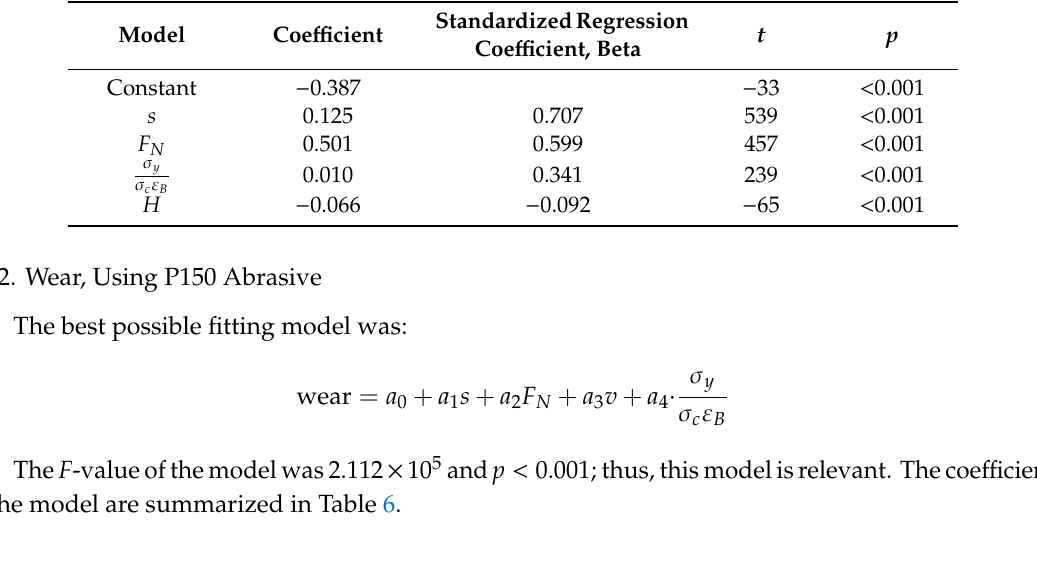
Table 5. Coe ffi cients of the regression model with P60